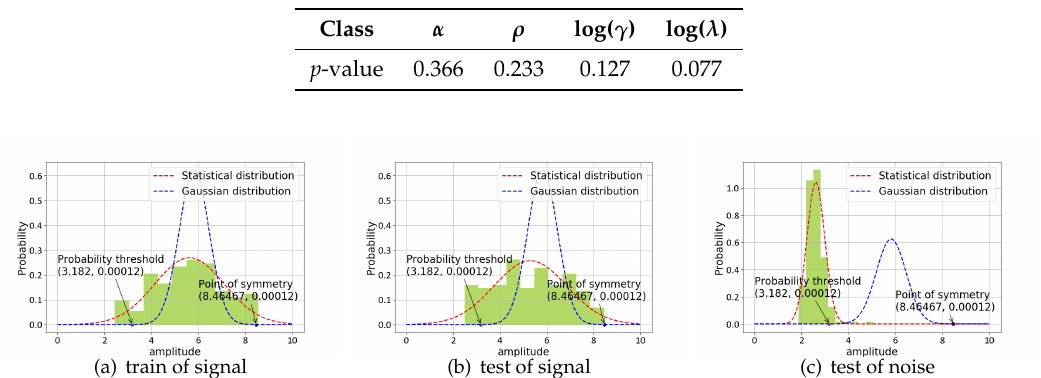
Table 2. The Kolmogorov–Smirnov (KS) test results of features.